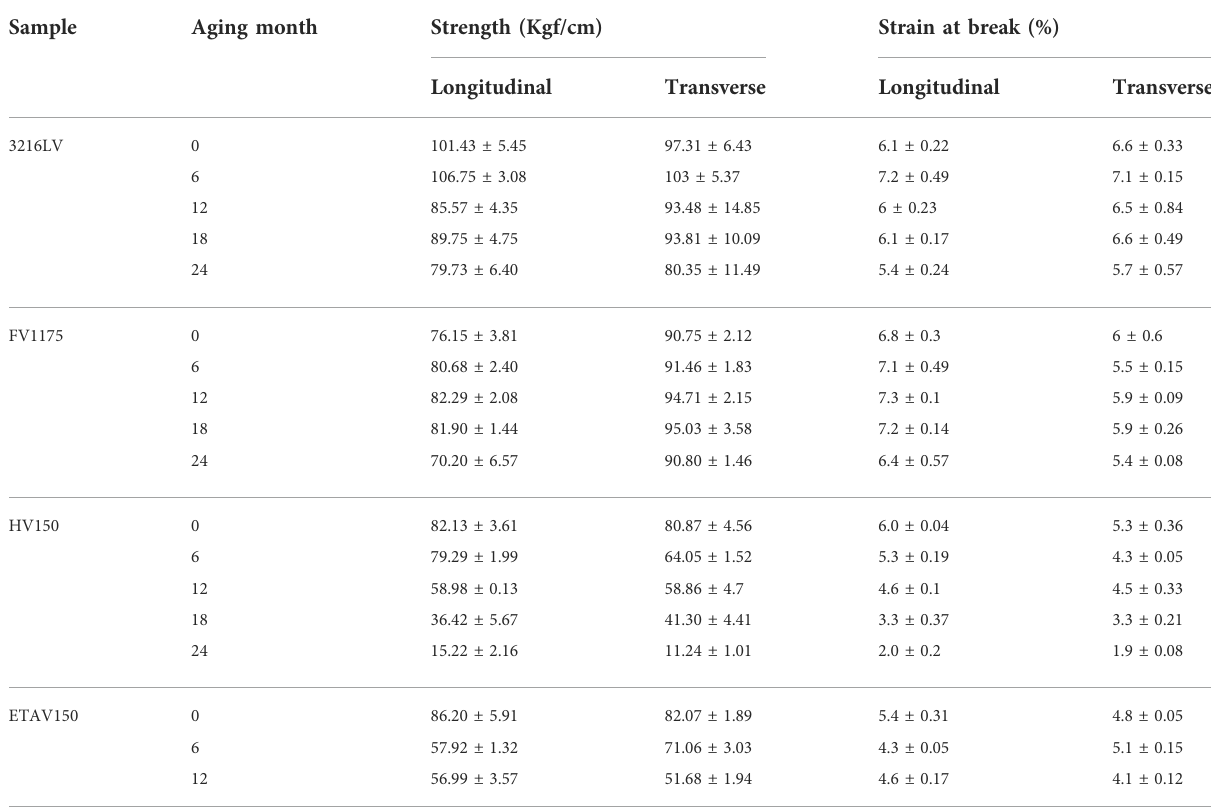
TABLE 4 Mechanical properties and helium permeability of envelopes aged for different times.